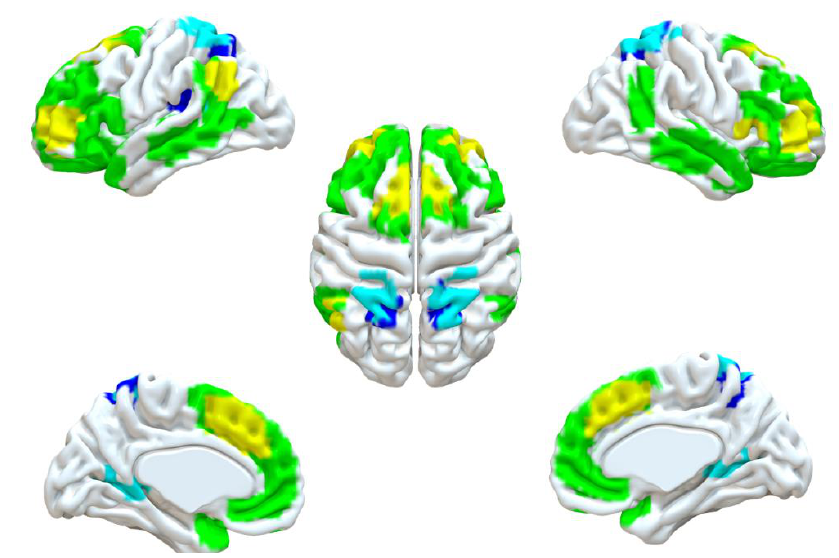
Figure 2. The results of sensitivity analyses (excluding treated patients).